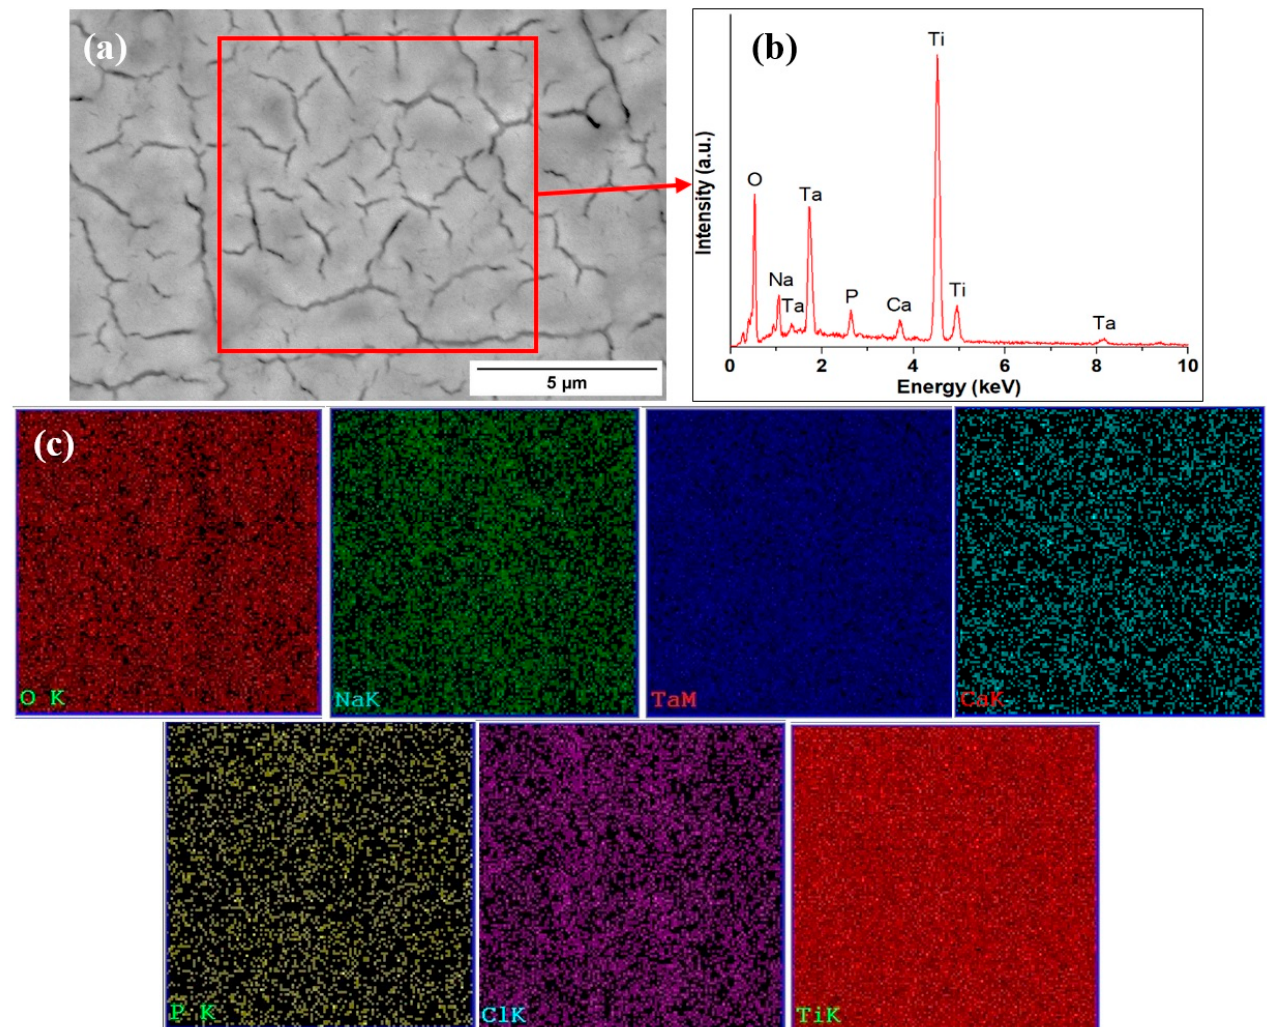
Figure 8. Microstructure of Ti-15Ta substrate treated with 10 M NaOH after exposure to simulated body fluid with afferent chemical composition—( a ) Ti-15%Ta; ( b ) EDS on selected area; ( c ) elemental mapping. Table 2. Hardness measurements on Ti-xTa